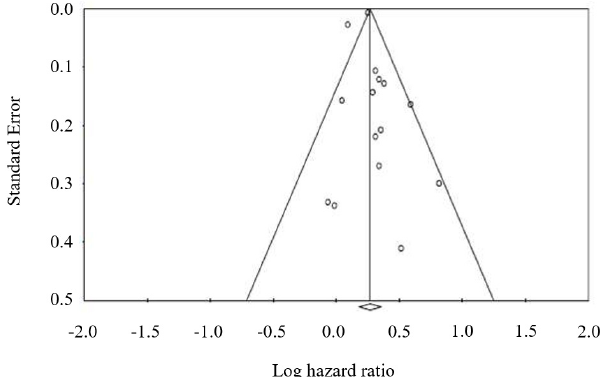
Figure 5. Funnel plot for publication bias in overall survival analysis.